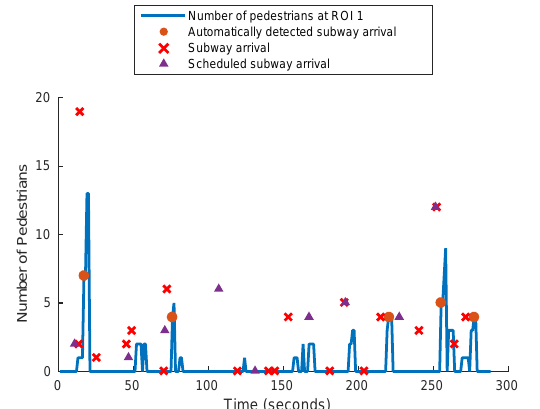
Figure 6: Snapshot of the dynamic graph derived from pedestrian